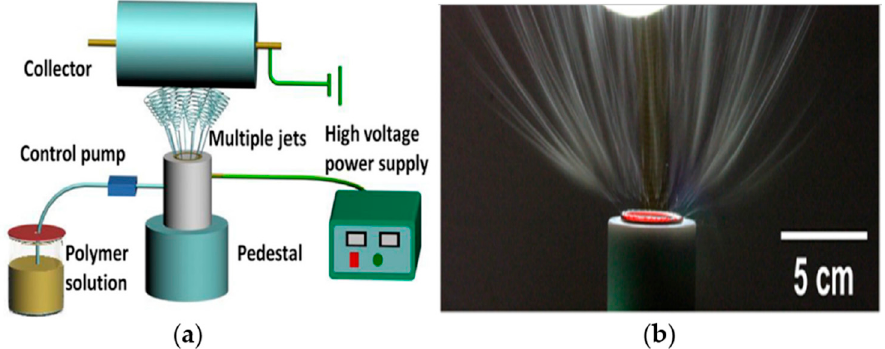
Figure 5. ( a ) Schematic diagram of a needleless electrospinning system, and ( b ) a photograph of the multiple jets forming in the needleless electrospinning process [103] (Copyright 2019, Elsevier).